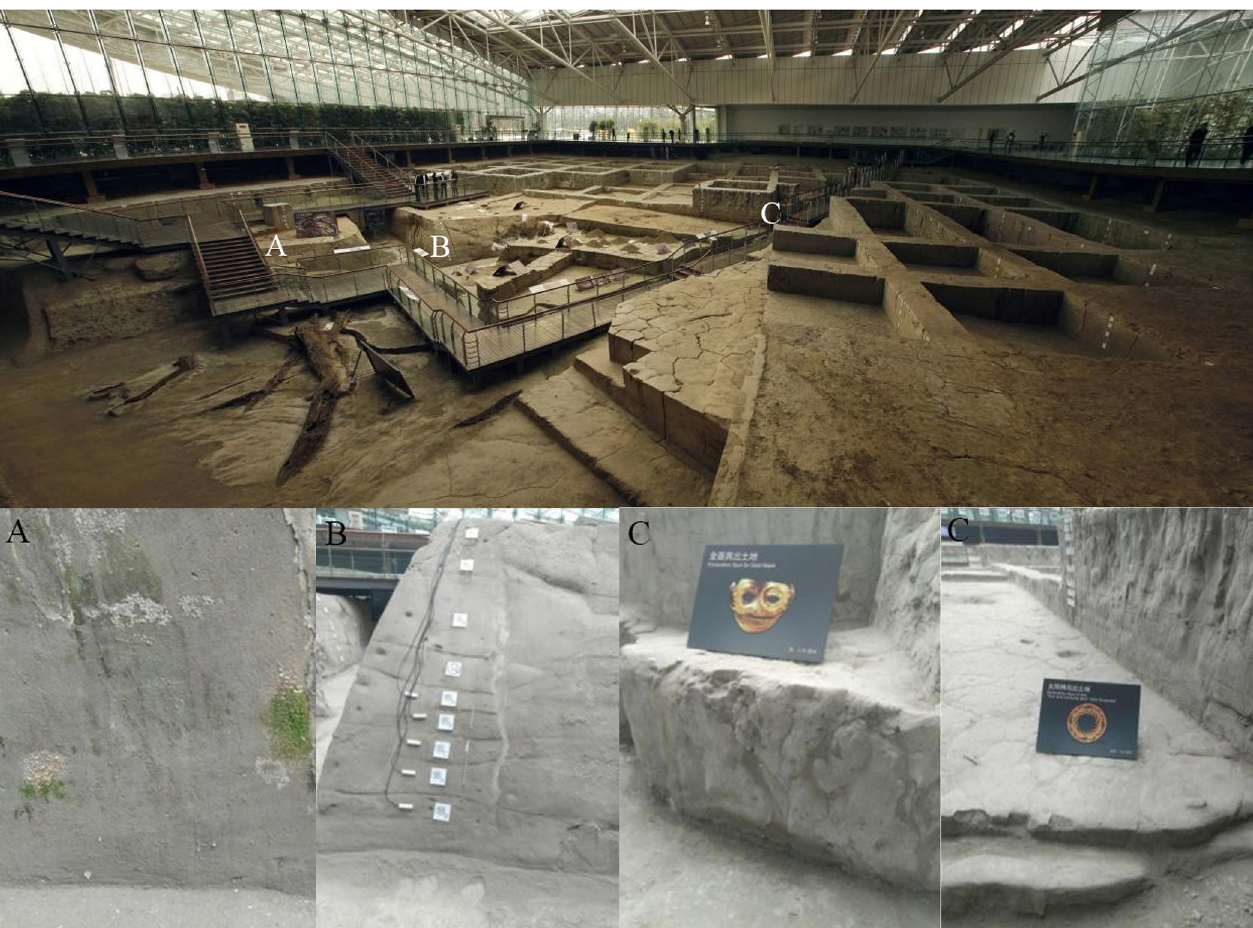
Fig 1. Panorama of Jinsha site and sampling